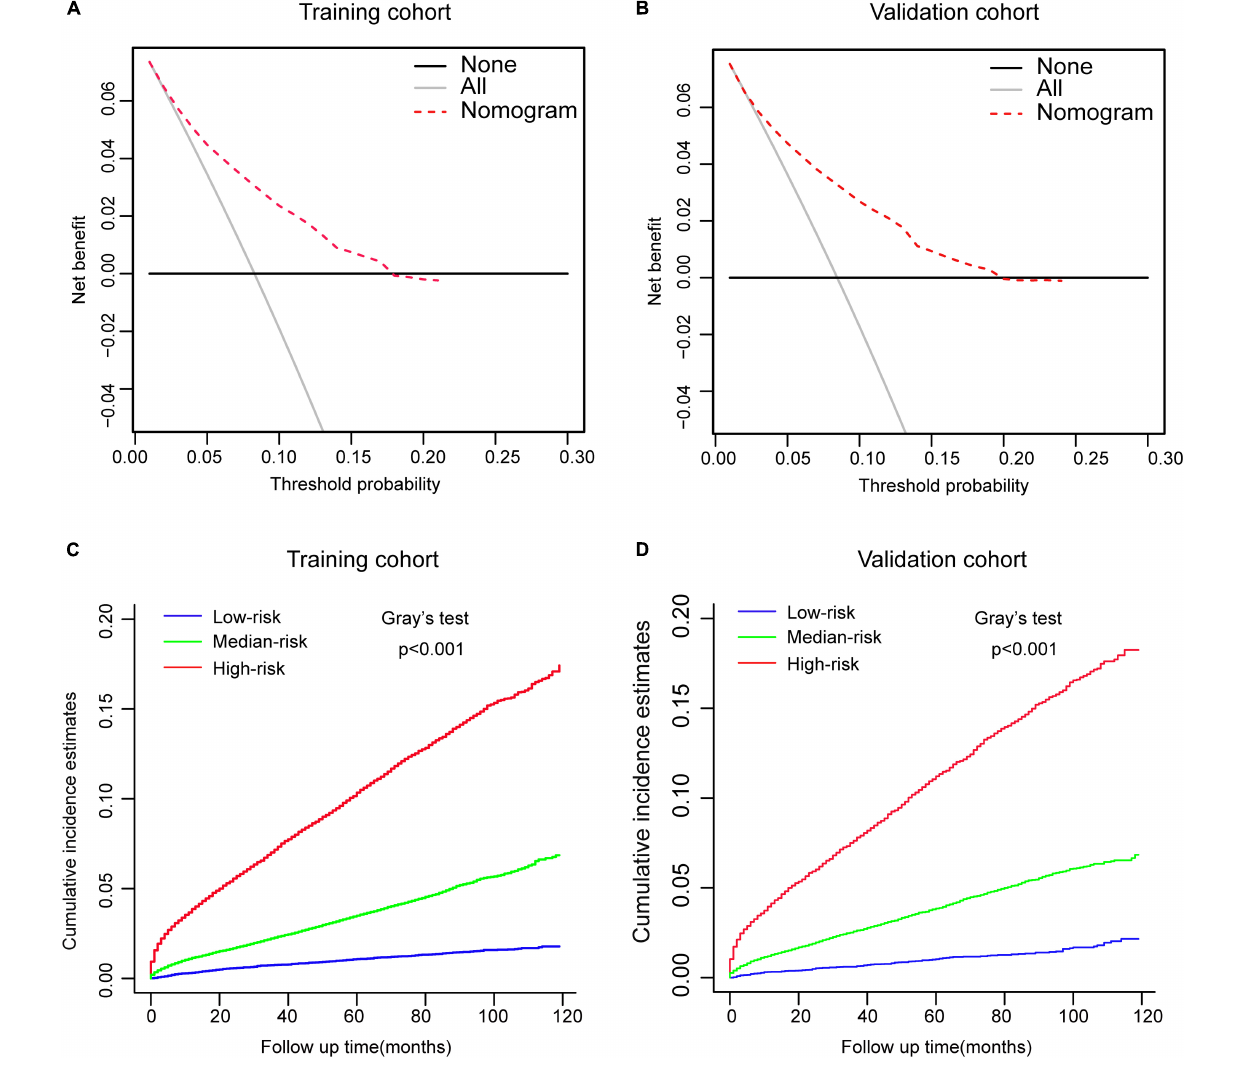
FIGURE 5 | Performance and risk stratification of the competing-risk model. (A,B) Decision curves of the nomogram predicting CVD in the training and validation cohort, respectively. (C,D) Cumulative incidence function (CIF) curves with the p -value of Gray’s test for the training and validation cohort,